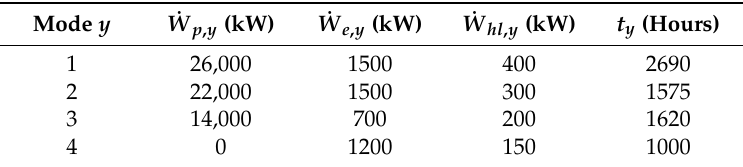
Table 3. Annual energy profile of the